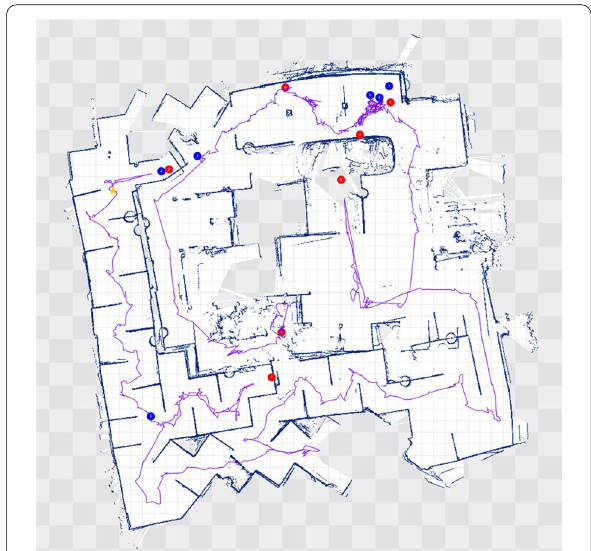
Fig. 17 This figure illustrates a merged 2D map by Karo and another complementary robot in the mission which exemplifies a collective behavior [47, 48]. In this map, the blue lines represent the obstacles where blue and red spots stand for decoded QR codes using image caption generation method [49] and the detected victims, respectively. Moreover, the purple lines correspond to the paths taken by